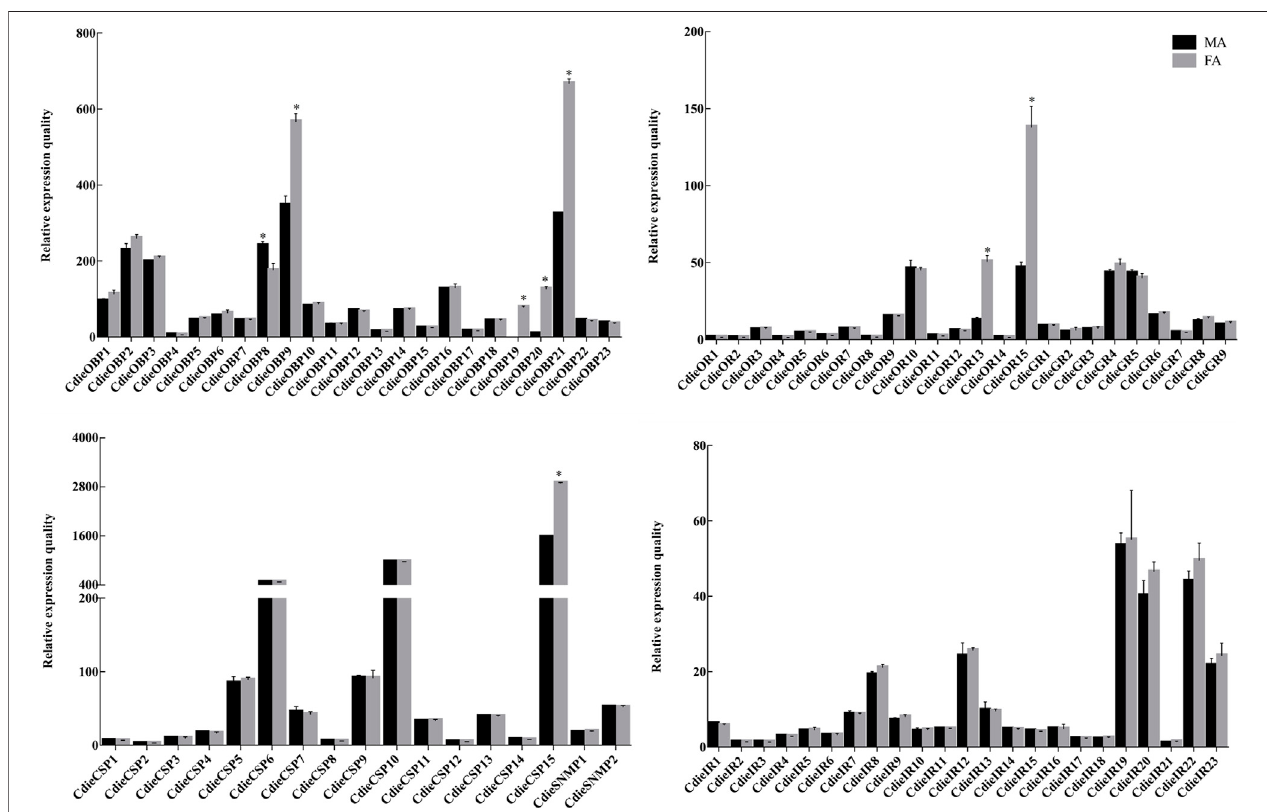
FIGURE 10 | Relative expression levels of chemosensory genes in C. dieckmanni OBPs. FA: Female antennae; MA: Male antennae. The asterisks above each bar represent signi fi cant differences ( p < 0.05).